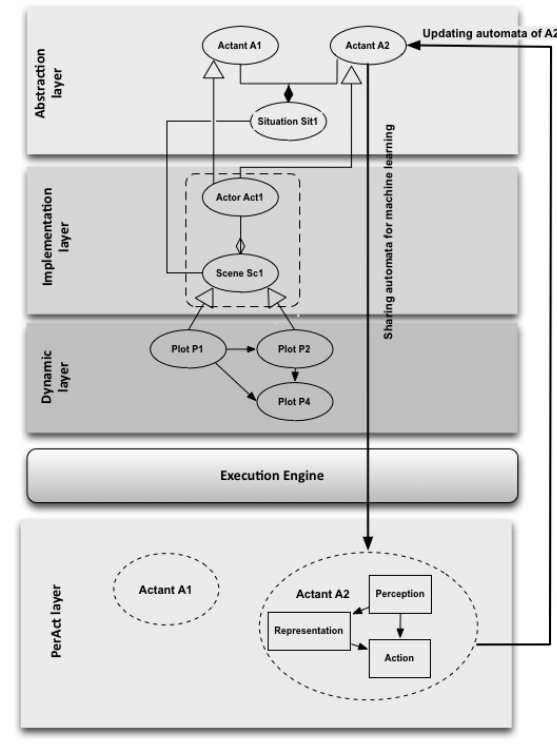
Figure 5. The proposed hybrid